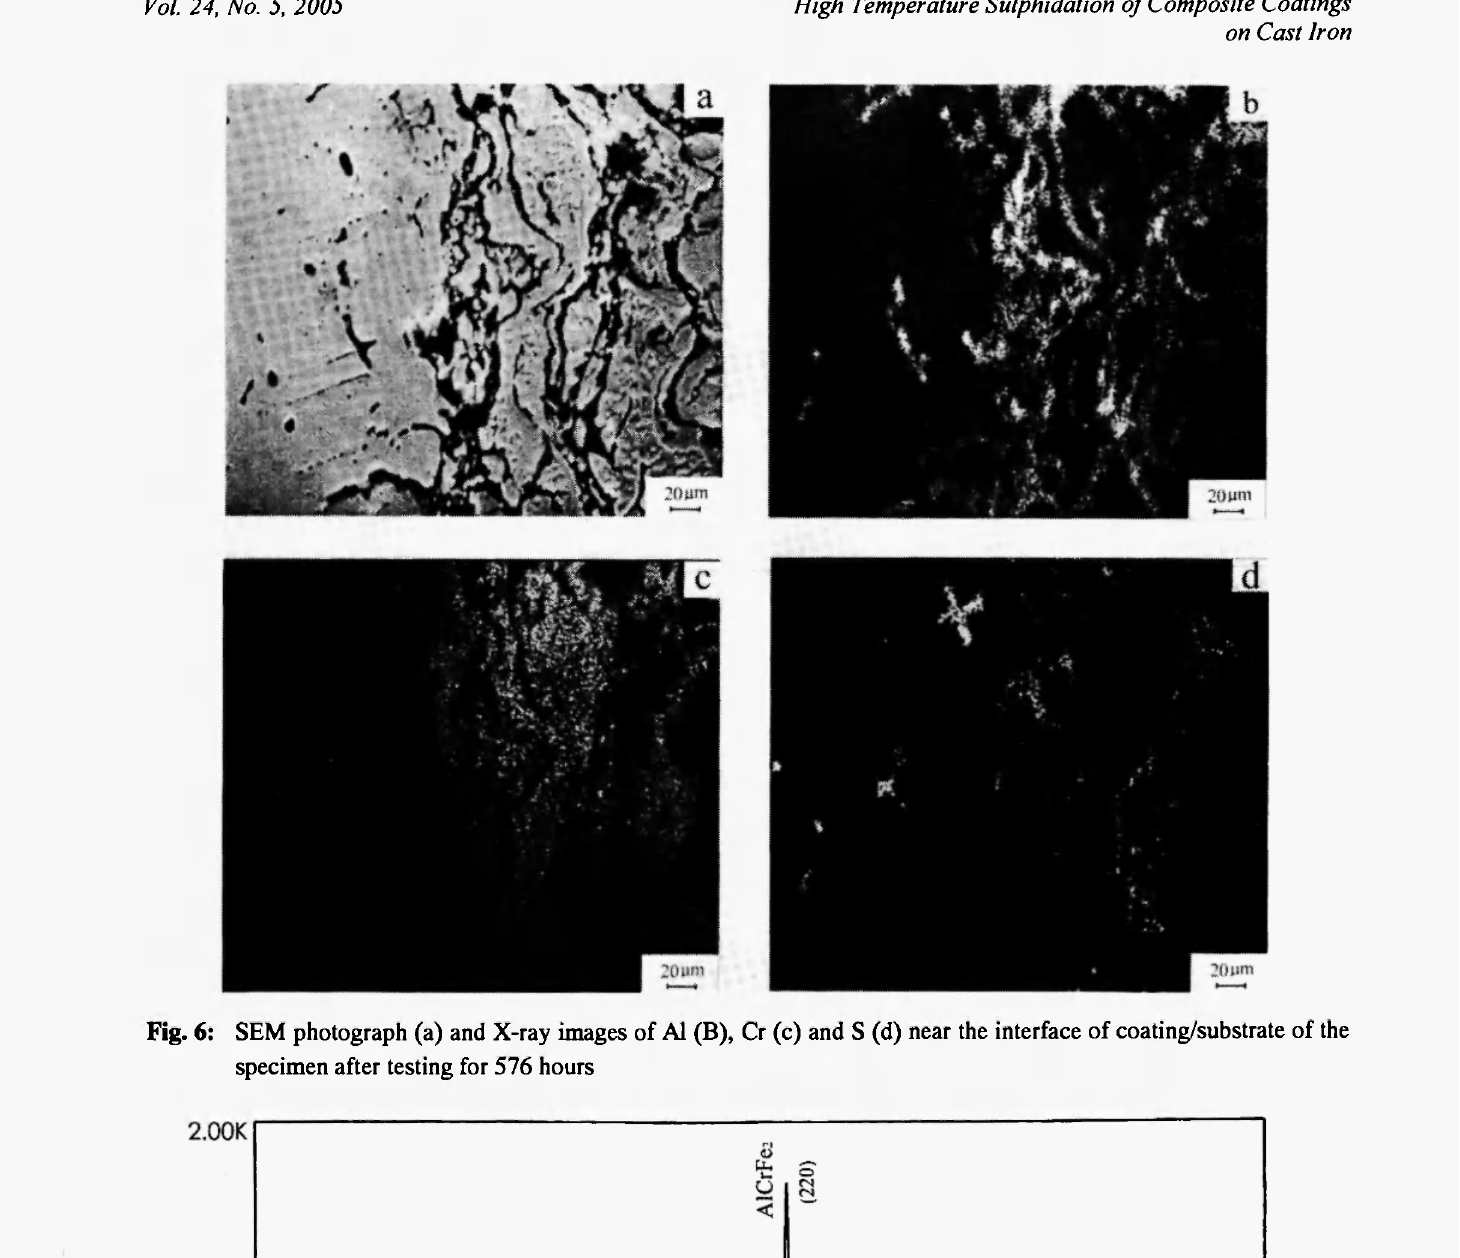
Fig. 6: SEM photograph (a) and X-ray images of ΑΙ (Β), Cr (c) and S (d) near the interface of coating/substrate of the specimen after testing for 576 hours